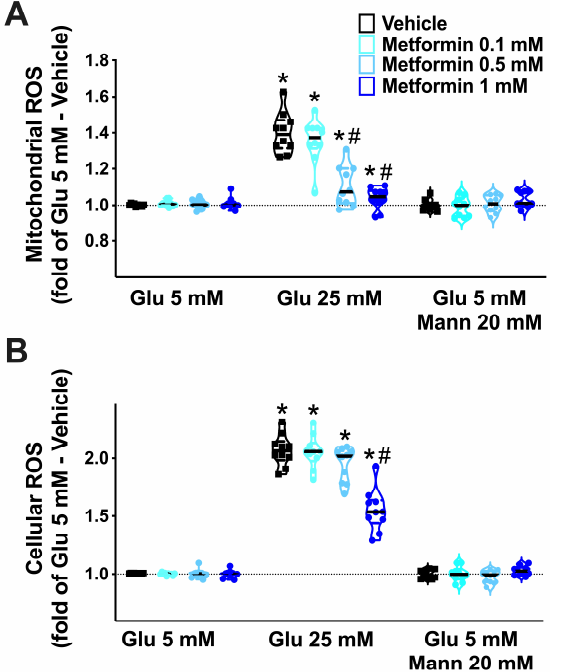
Figure 5. Effects of metformin on the generation of reactive oxygen species (ROS). We evaluated the effects of increasing doses of metformin on the production of mitochondrial ( A ) and cellular ( B ) ROS in human brain microvascular endothelial cells cultured at the indicated conditions (Glu: